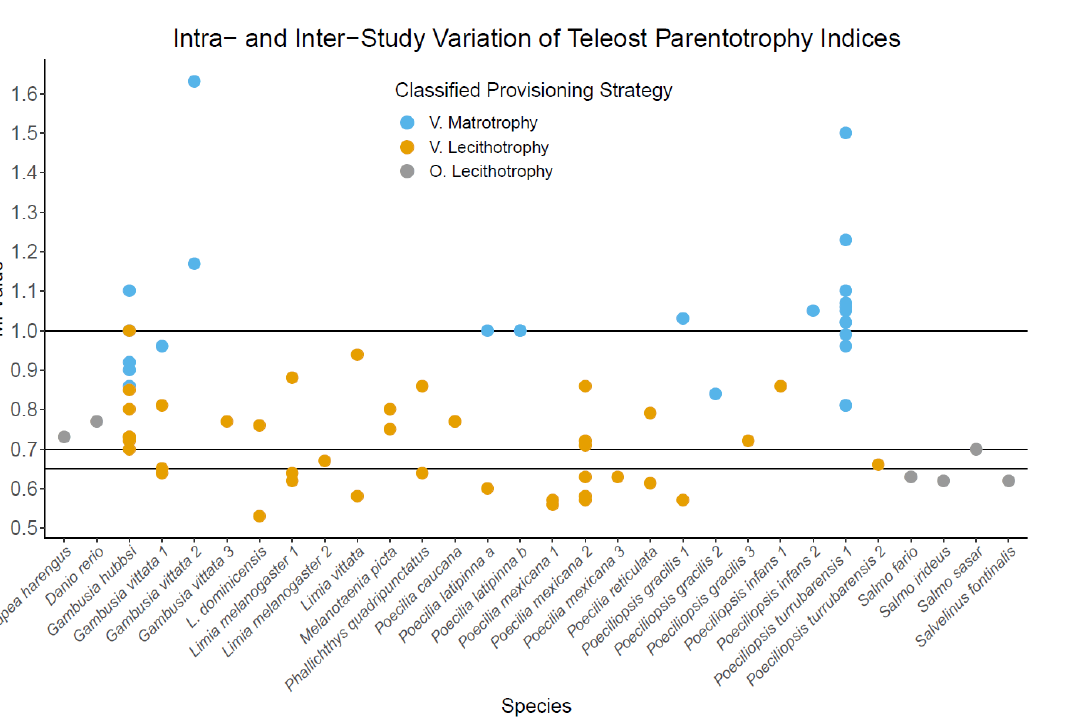
Figure 1. The variation in matrotrophy indices and parentotrophy classifications between populations of teleosts. Each species along the x -axis represents a single study, except for Poecilia latipinna (a & b), which come from a single study and represent two populations (population a & population b) one year apart. If there are multiple studies for a single species, each study is separated by species name followed by a number (1 – 3). Each plotted value for each species represents a separate population within a study, except for Poeciliopsis gracilis 1, which represents the same population across the wet season (classified as lecithotrophy) and dry season (classified as matrotrophy), and Poecilia latipinna. All viviparous MI values were estimated using regression models except for Poeciliopsis turrubararensis and all oviparous species, which used raw mean values. Poecilia caucana includes two populations with an MI of 0.77. The provisioning strategy presented was assigned by each paper based on their specified threshold and statistics. The varying threshold MI and PI values used to classify parentotrophy in different studies are >0.65, >0.7, or ≥1, represented by horizontal lines. There was either no sta- tistics or confirmation of parentotrophy was done by determining whether the population MI was significantly different to 0.7 (refer to Table 1). (V.) represents viviparous species in which an MI has been calculated for at least two populations. (O.) represents oviparous, lecithotrophic species, which were included for